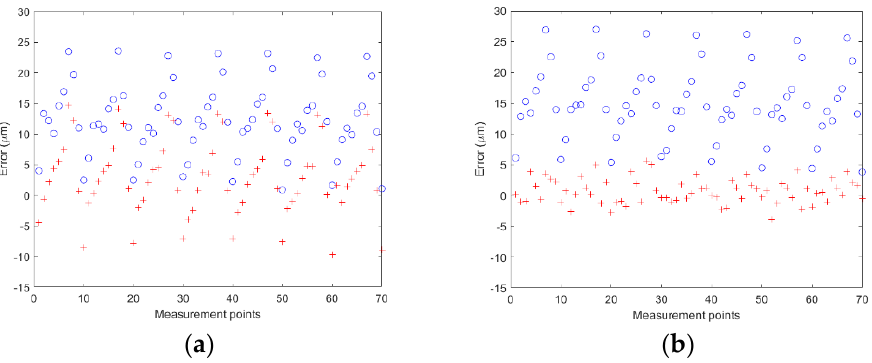
Figure 10. ( a ) The error distribution of replica one before (blue circles) and after (red plus signs) tool radius compensation for Surface one; ( b ) the error distribution of replica one before (blue circles) and after (red plus signs) mirror compensation for Surface one.